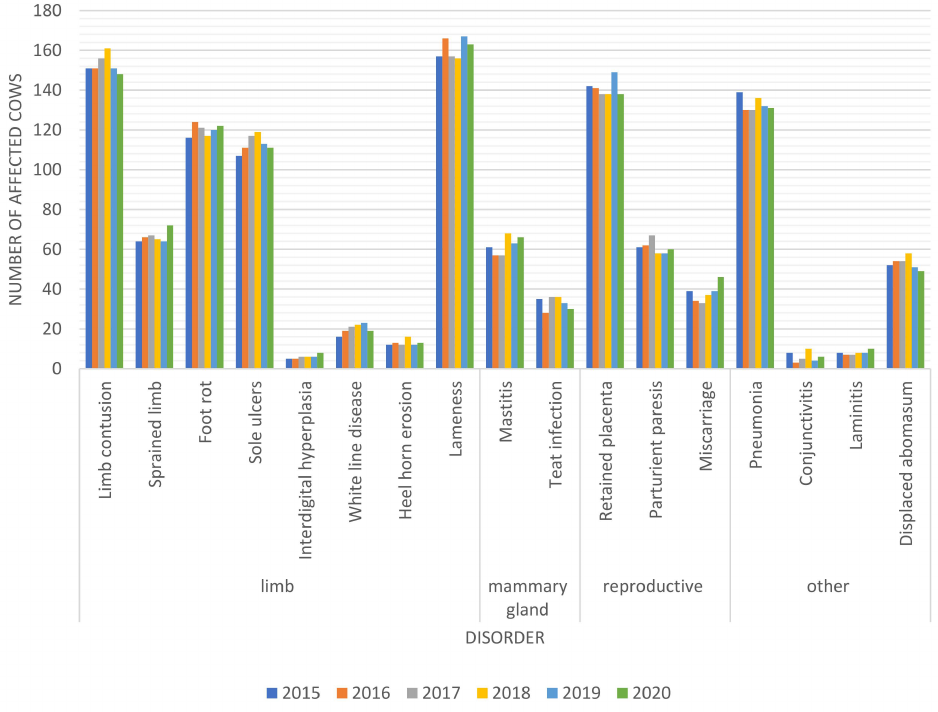
Figure 7. Prevalence of different diseases in the entire cow population in successive years of the study